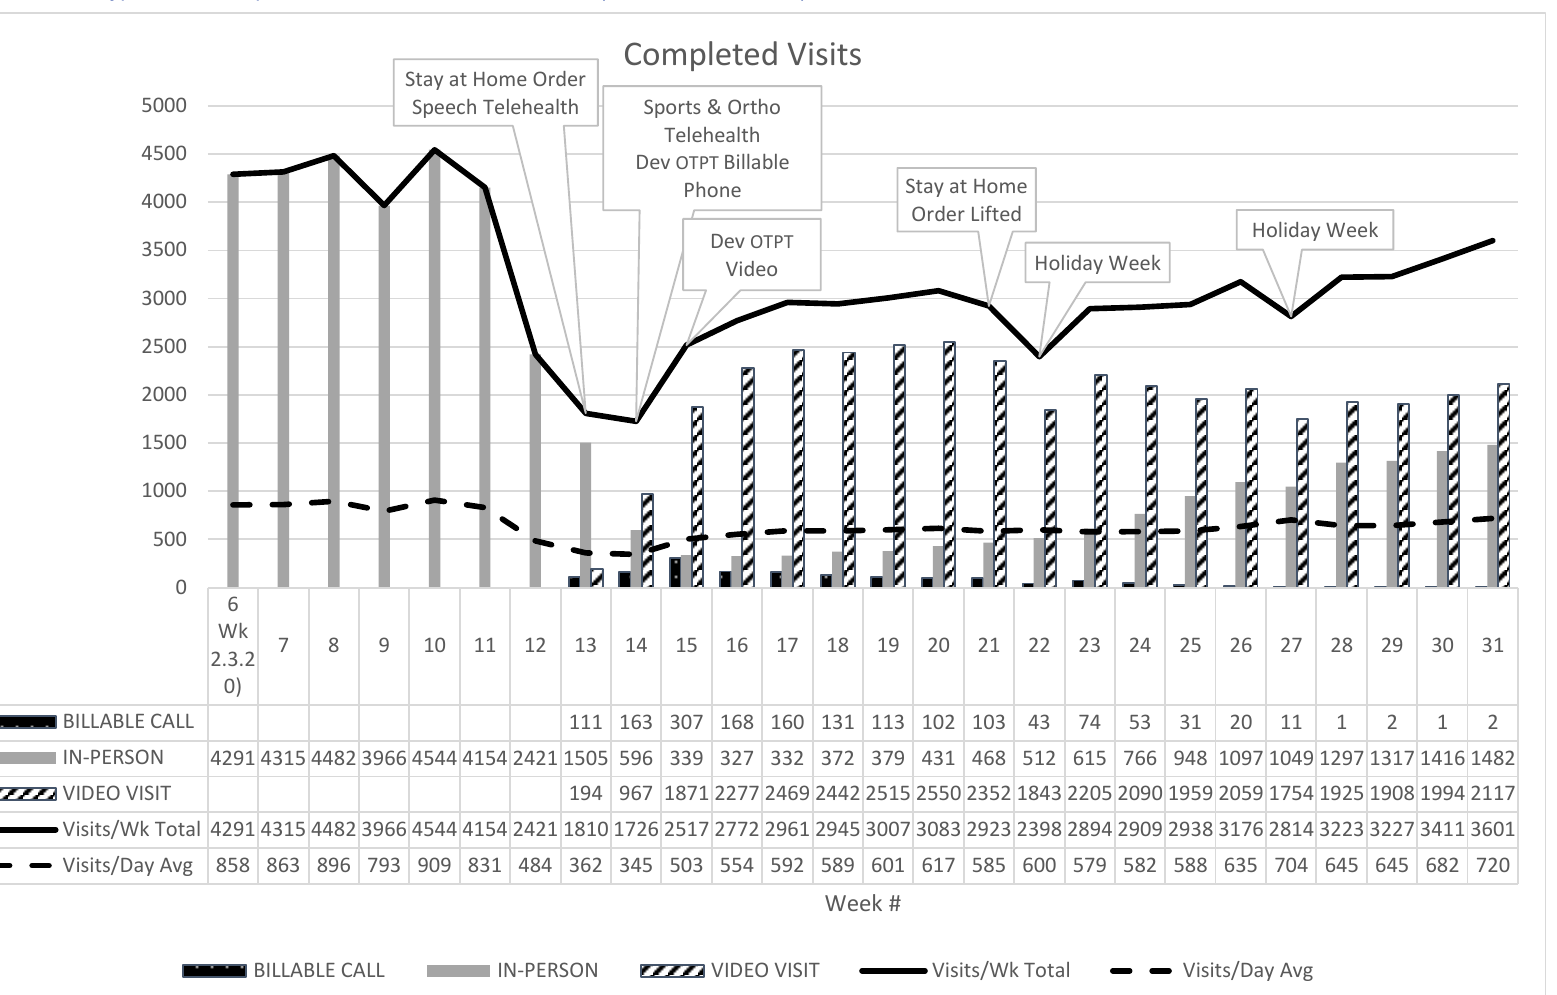
Completed Visit Types for All Departments Over a 26-week Period (2/3/2020-7/31/2020)